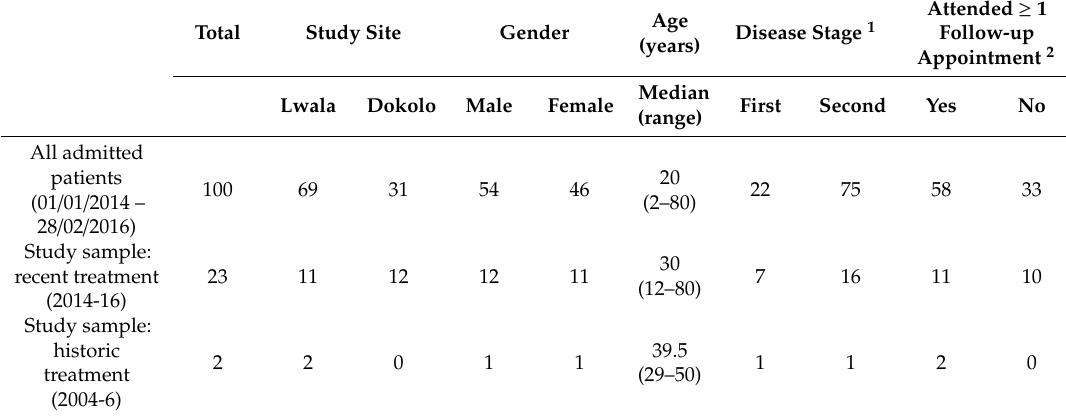
Table 1. Patient